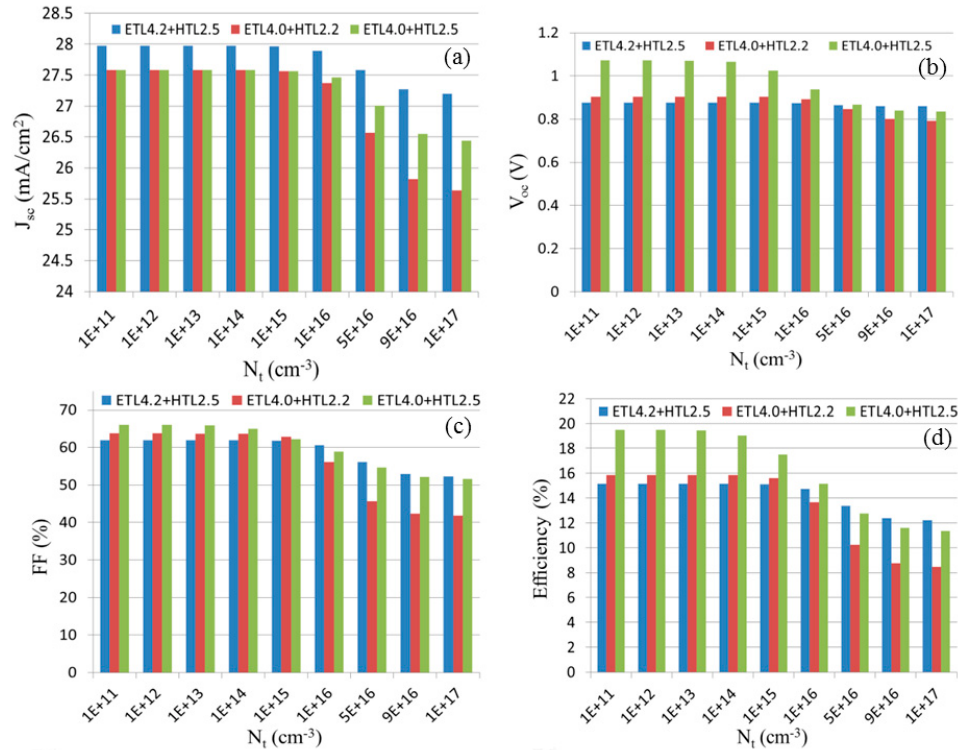
Figure 9. Effect of electron affinity of the TL on the ( a ) J sc , ( b ) V oc , ( c ) FF and ( d ) efficiency of the solar cell.